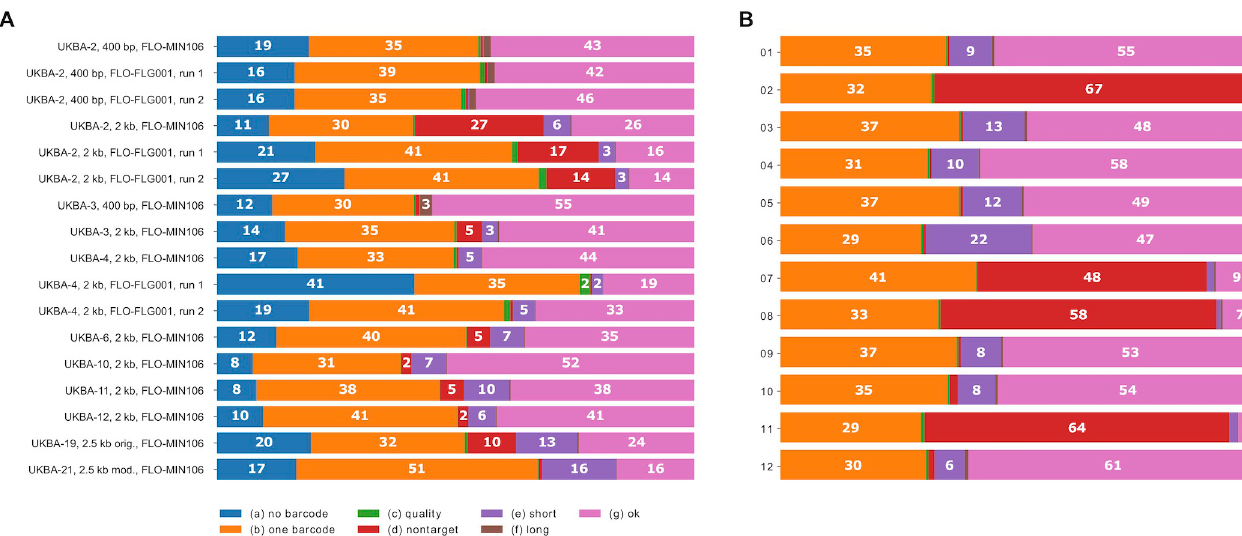
Fig 2. Reasons for discarding reads in the Artic pipeline. The sequencing reads must pass through a series of filters to ensure correct sample assignment and the read quality. The bar graphs show the percentage of reads discarded for various reasons as well as those passing all filters. Panel (A): Summary per run. Panel (B): Detailed per-barcode analysis for UKBA-2 samples, 2-kb amplicons, standard flow cell. Group (a): reads without barcode identification. Group (b): reads with only one barcode (Artic pipeline requires barcodes on both ends to ensure that the whole read was sequenced and to decrease the probability of barcode bleeding). Group (c): low-quality reads (base caller quality less than 7). Group (d): reads that do not align to the SARS-CoV-2 reference. Group (e): reads that are too short (likely due to fragmentation). Group (f): reads that are too long ( i . e . chimeric reads). The pipeline keeps reads of lengths between 1500 and 3000 for 2-kb amplicons, between 350 and 619 for 400-bp amplicons. The reads passing all filters are included in group (g).